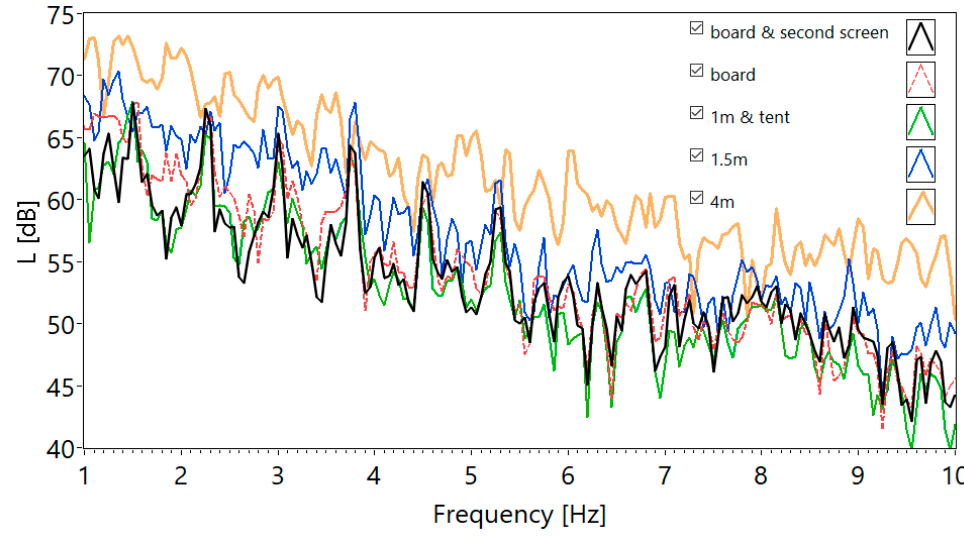
Figure 18. Wind turbine noise. FFT spectrum, average wind speed—3.5 m/s, max wind speed—6.7 m/s.